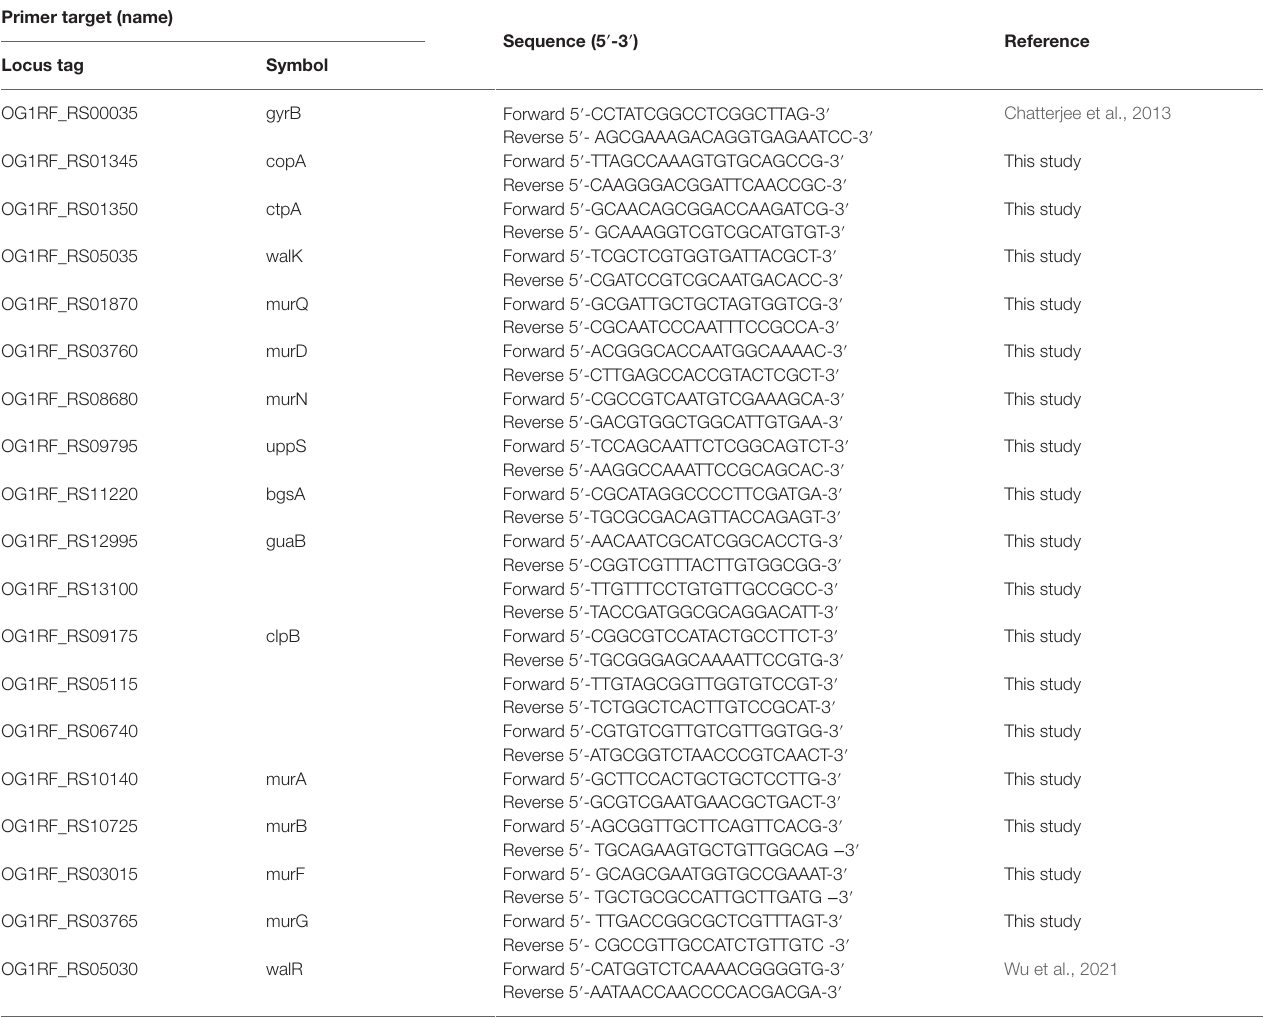
Sequence (5 ′ -3 ′ ) Reference